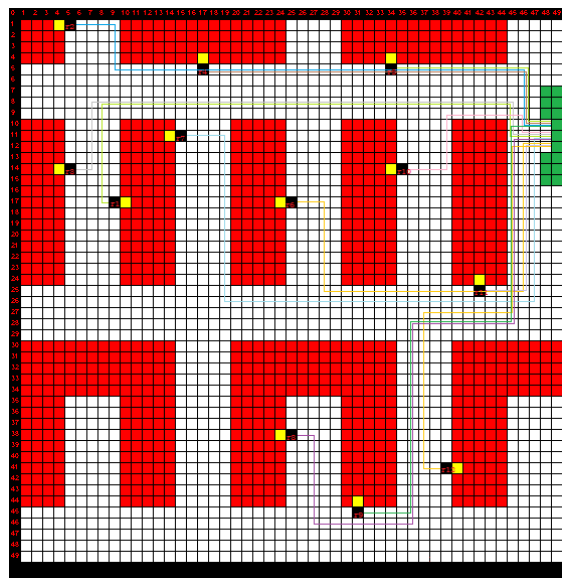
Figure 6. An example synthetic environment, including the robots.